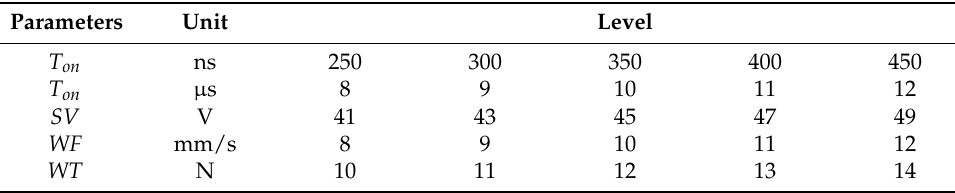
Table 2. Process parameters and their levels.